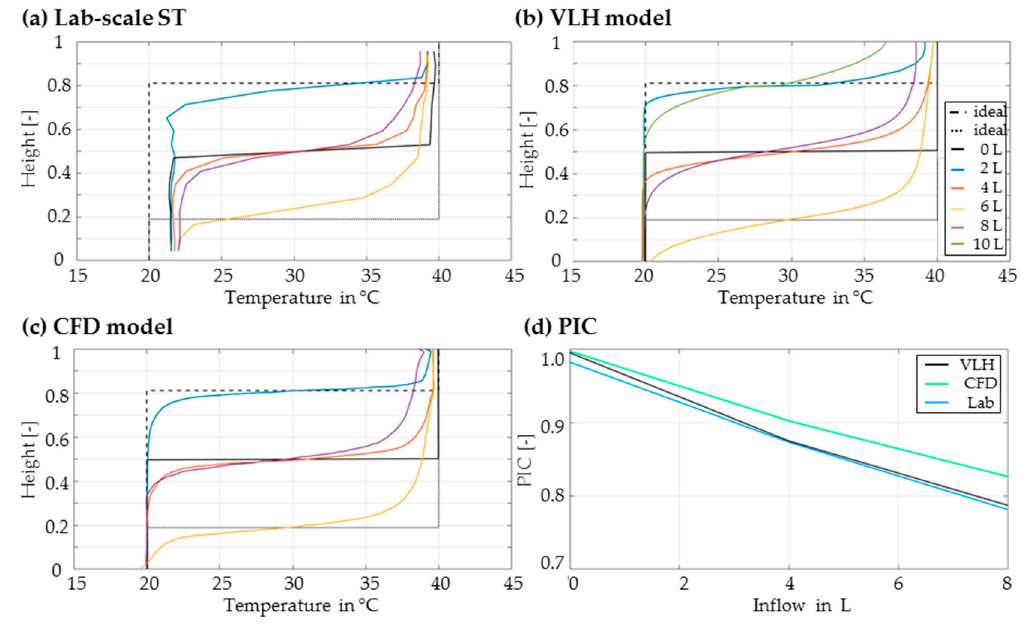
Figure 9. Thermocline Movement for a targeted tank charging sequence in comparison to the ideal position for the ( a ) lab, ( b ) VLH model and ( c ) CFD model, compared based on the ( d ) PIC value.